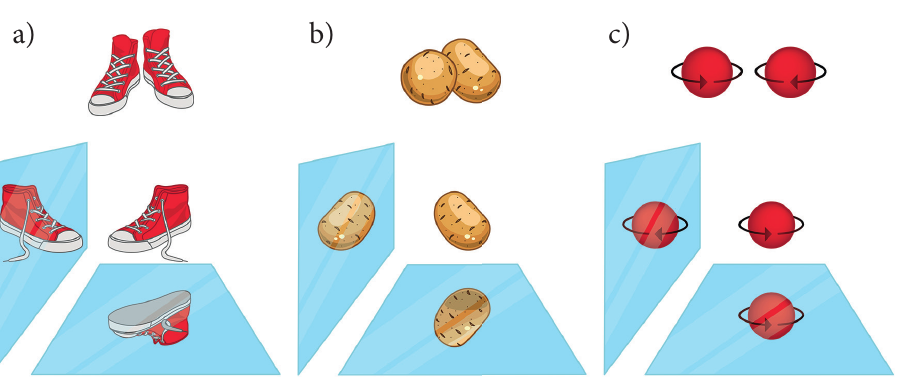
Figure 1. Chirality and handedness. ( a ) A pair of shoes is chiral and handed. The right shoe is the mirror image of the left shoe, but none of the mirror images coincide with itself; ( b ) potatoes are chiral because there exists no mirror operation that transform them into themselves; however, they are not handed, and there exist no left- or right-handed potatoes; ( c ) a rotating ball can exhibit a left (clockwise) or a right ( “handed” ) (anti-clockwise) rotation and thus it may be called handed; however, one of its mirror images coincided with itself and therefore it is not chiral but